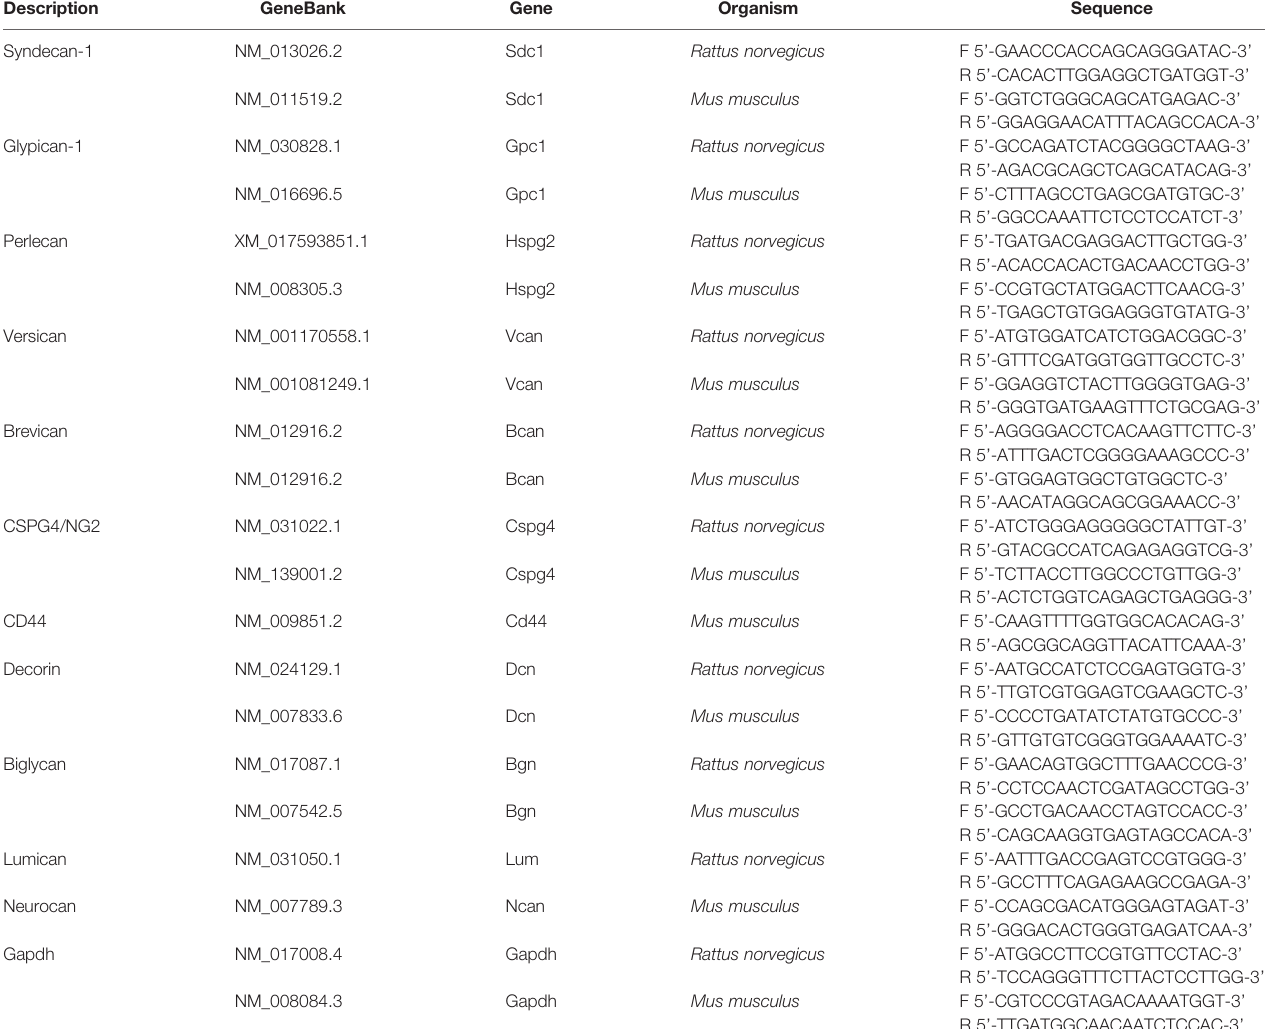
TABLE 1 | Sequences of primers used in PCR